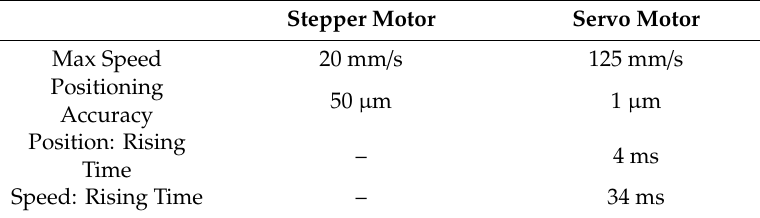
Figure 17. Speed feedback measurement. Table 5. Stepper motor and servo motor comparison table.